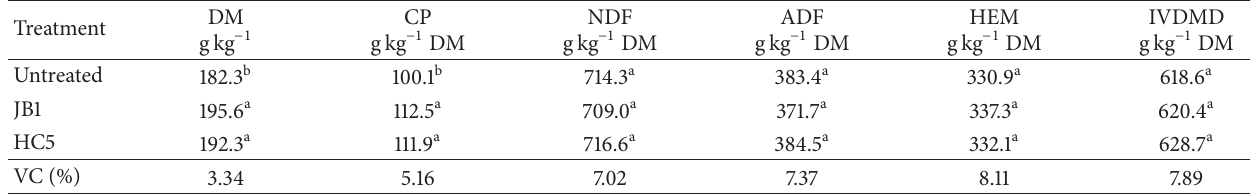
Table 5: Chemical composition and in vitro digestibility of Tanzania grass silage. Treatment